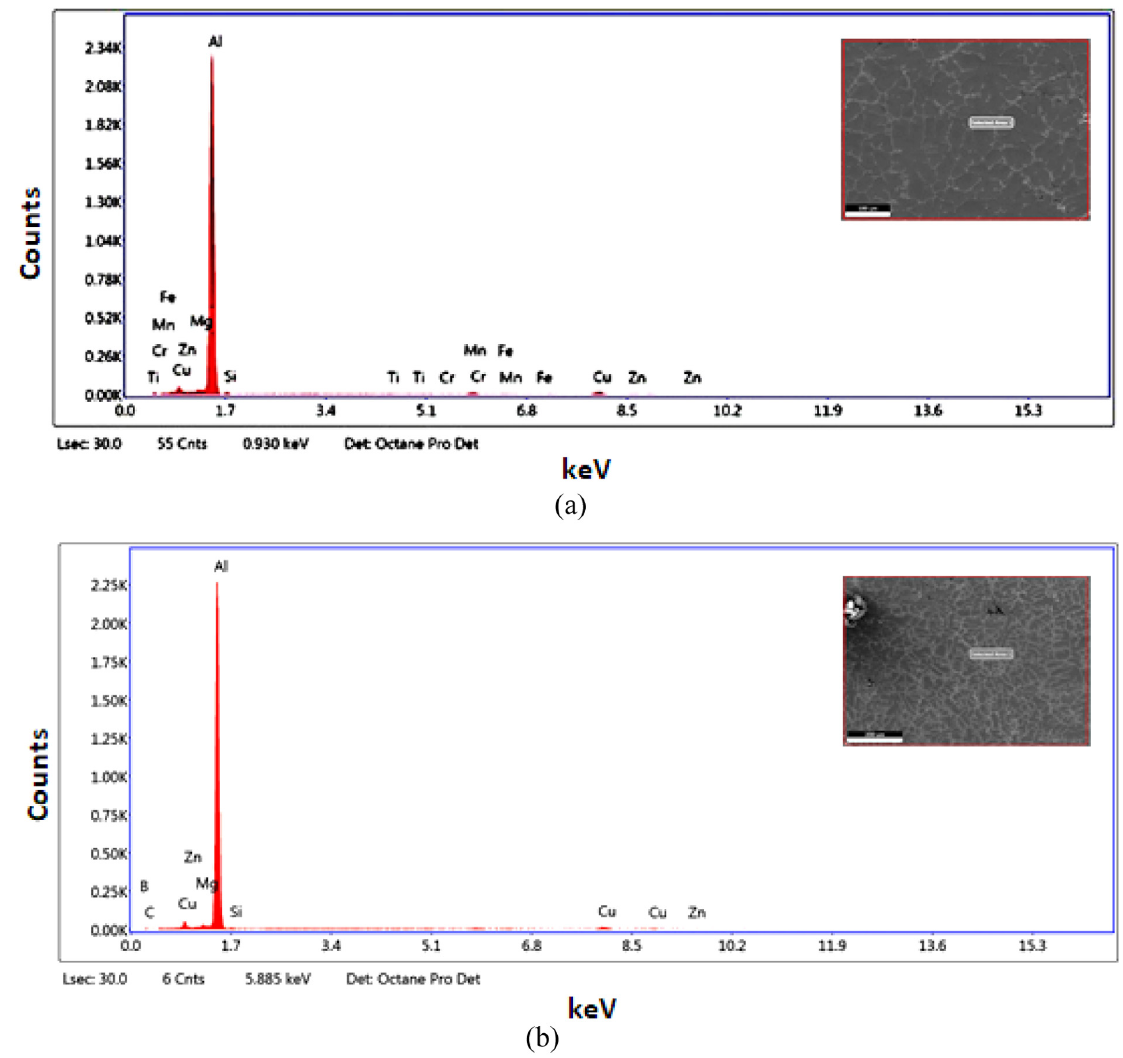
Fig. 6. EDS spectrum of (a) Al7049 alloy (b) Al7049-8 wt.% of B 4 C